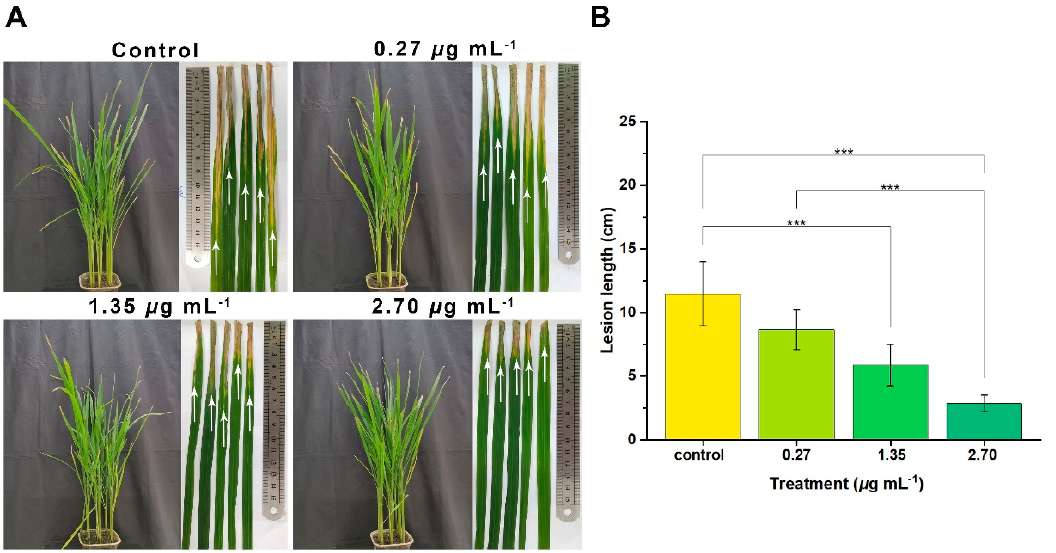
Figure 9. Effects of compound 2b on the representative Xanthomonas oryzae pv. oryzae ’s ( Xoo ) responses to the rice bacterial leaf blight disease. ( A ) The leaf-clipping method was used to co-incubate rice leaves with the Xoo cell suspension after exposure to doses 0 (served as blank), 0.27, 1.35, and 2.70 μ g mL − 1 of compound 2b for 24 h. ( B ) The length of a lathy lesion of rice leaves was measured in Xoo at various doses of compound 2b [(***) p < 0.001 vs. 0].